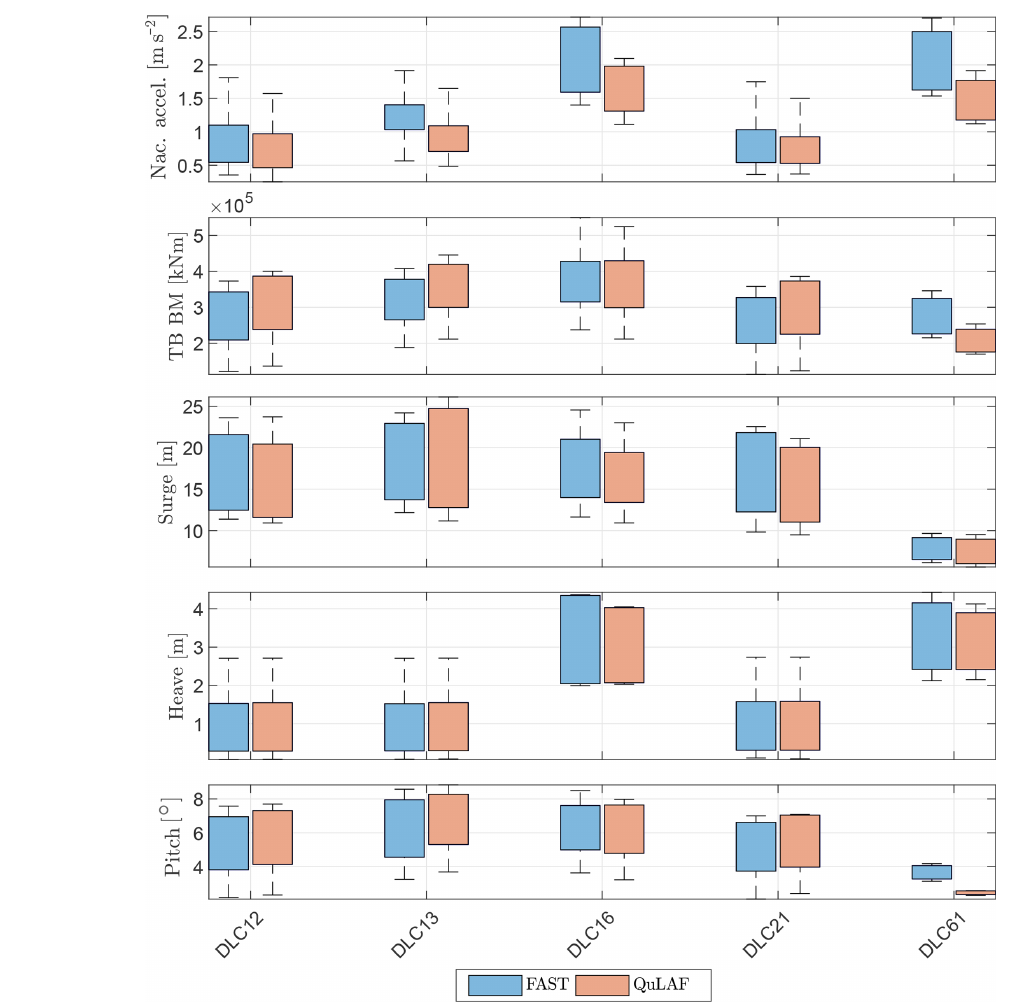
Figure 9. Population of max. values for each of the five load cases.